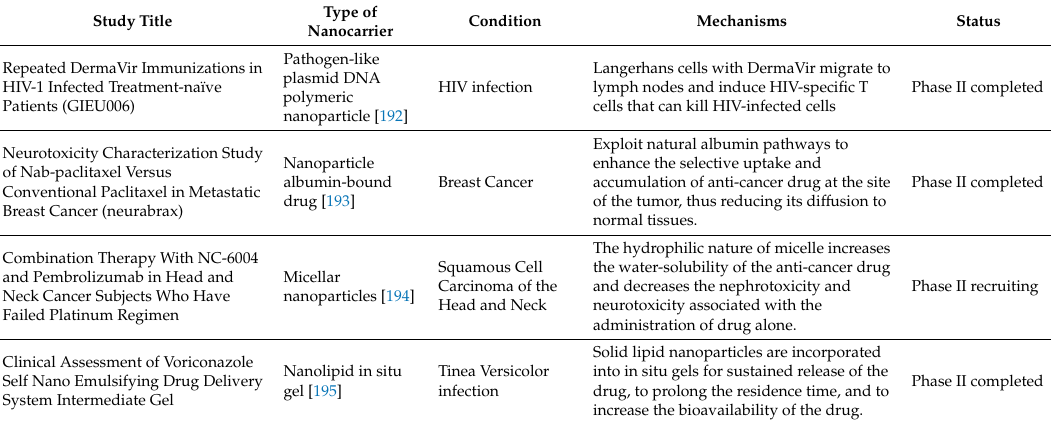
Table 3. Examples of nanocarriers currently on phase II / III clinical